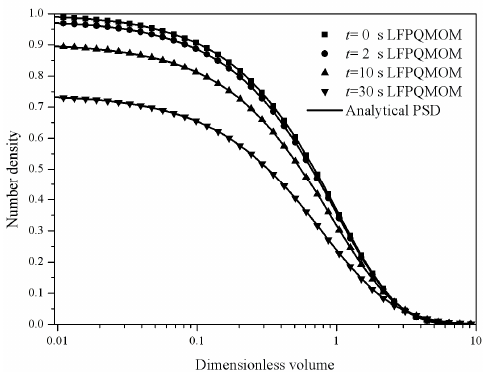
Figure 8. Particle size distribution at 0, 2, 10, and 30 s for the pure aggregation with sum kernel and exponential initial PSD (square: numerical PSD at 0 s; circle: numerical PSD at 2 s; up triangle: numerical PSD at 10 s; down triangle: numerical PSD at 30 s; line: analytical PSD).